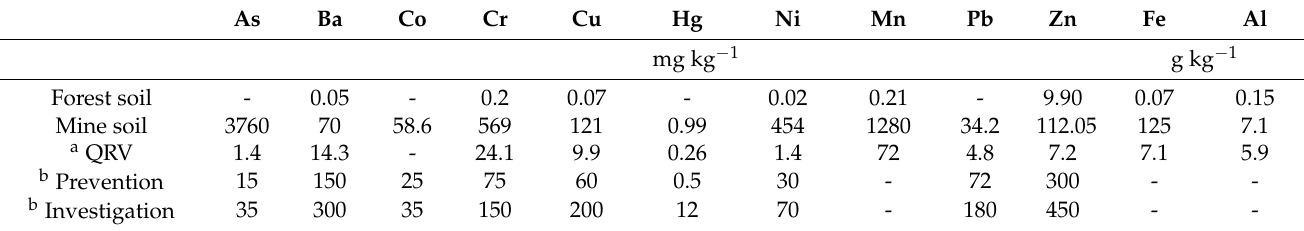
Table 5. Content of potentially toxic elements in gold mining soil in Cachoeira do Piri á , Par á